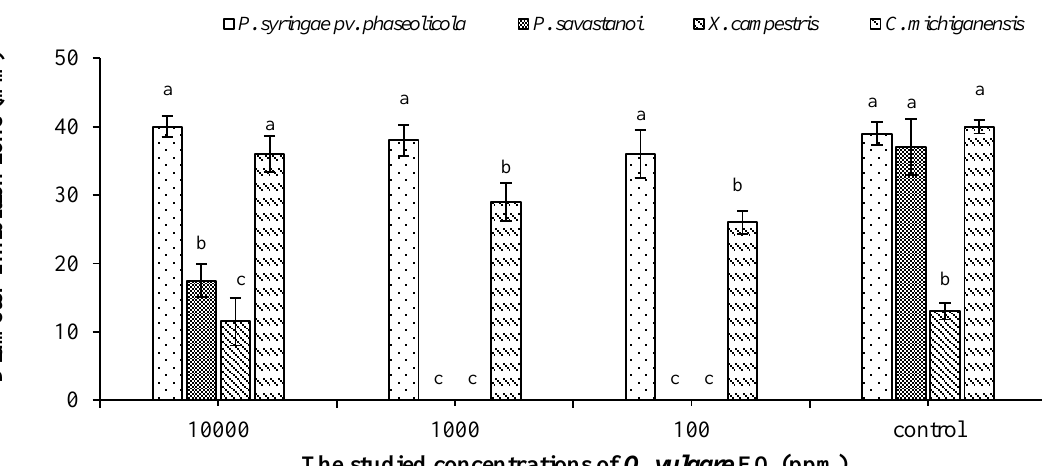
Figure 2. Antibacterial activity of Origanum vulgare EO Bars with different letters for each tested EO dose indicate mean values significantly different at p < 0.05 according to Tukey (B) test. Data are expressed as mean of three replicates ± SD.